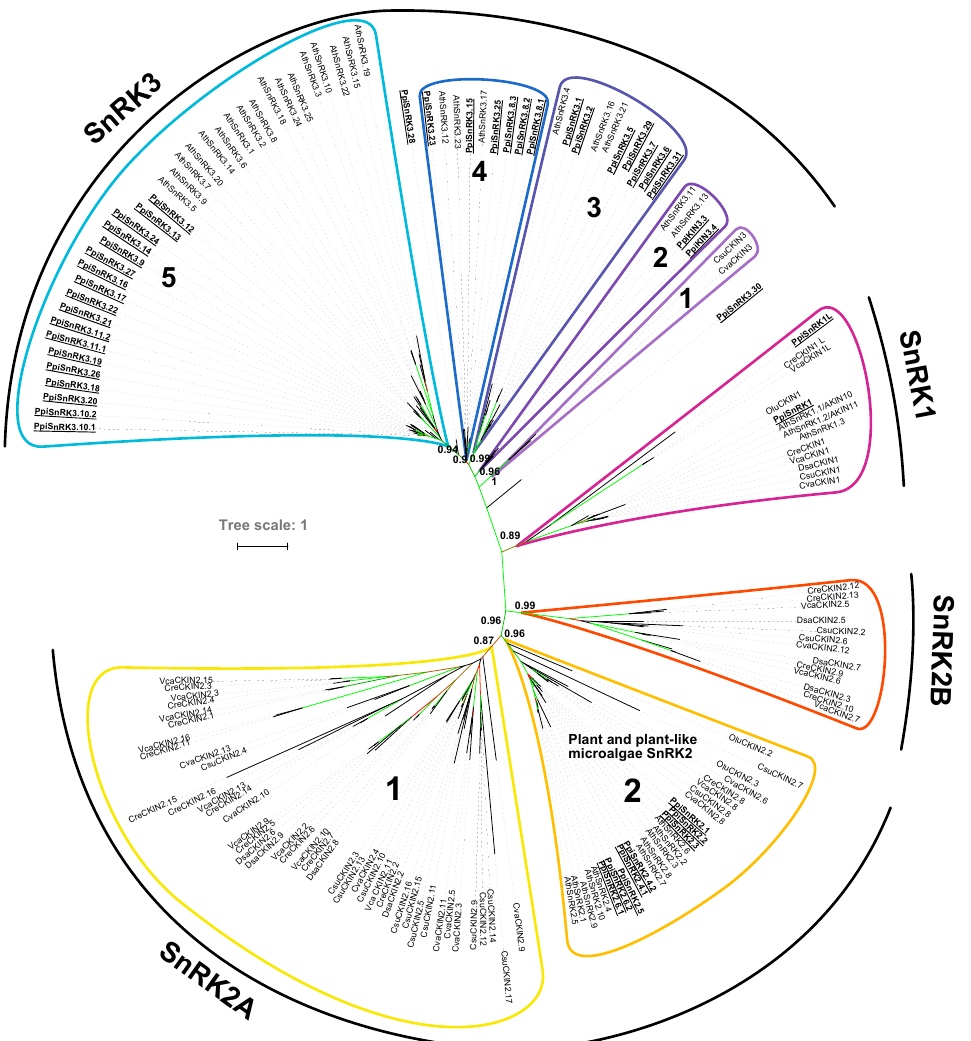
Figure 1. Unrooted maximum likelihood (ML) tree of Pinus pinaster (PpiSnRK) and Arabidopsis thaliana (AthSnRK) SnRK sequences along their orthologs into different microalgae species—CKIN—including Chlamydomonas reinhardtii (CreCKIN), Volvox carteri (VcaCKIN), Dunaliella salina (DsaCKIN), Chlorella variabilis (CvaCKIN), Coccomyxa subellipsoidea (CsuCKIN) and Ostreococcus lucimarinus (OluCKIN) SnRK sequences. Tree branches are colored according to their TBE bootstrap values. Branches with TBE values below 0.8 are black, while these above 0.8 TBE are colored from red (0.8) to light green (1). Tree divided the sequences into the tree SnRK families (SnRK1, 2, 3). SnRK1 subfamily was divided into SnRK1 like and SnRK1 sequences, SnRK3 sequences was divided into five different subgroups and SnRK2 sequences were divided between SnRK2A and SnRK2B. P. pinaster PpiSnRK2 sequences were all included into the SnRK2A group along Arabidopsis SnRK2s.